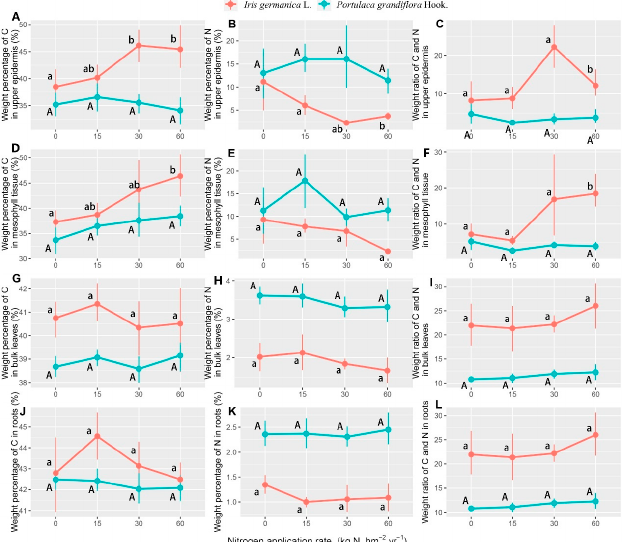
Figure 3. The response of the percentage weight of carbon (C), nitrogen (N), and C/N in the roots (R) ( A – C ), the upper epidermis (UE) ( D – F ), mesophyll tissue (MT) ( G – I ), and bulk of leaves (BL) ( J – L ) to the nitrogen application rate in the form of aerosols in Iris germanica L. and Portulaca gran- diflora Hook. (averages of two sampling seasons). Values are means with 95% bootstrapped confi- dence intervals (CI). Differences are significant at α = 0.05, when the CI does not overlap the subse- quent mean. Upper and lower case letters indicate the significantly different results of Portulaca grandiflora Hook. and Iris Germanica L. on applied nitrogen concentration, respectively.